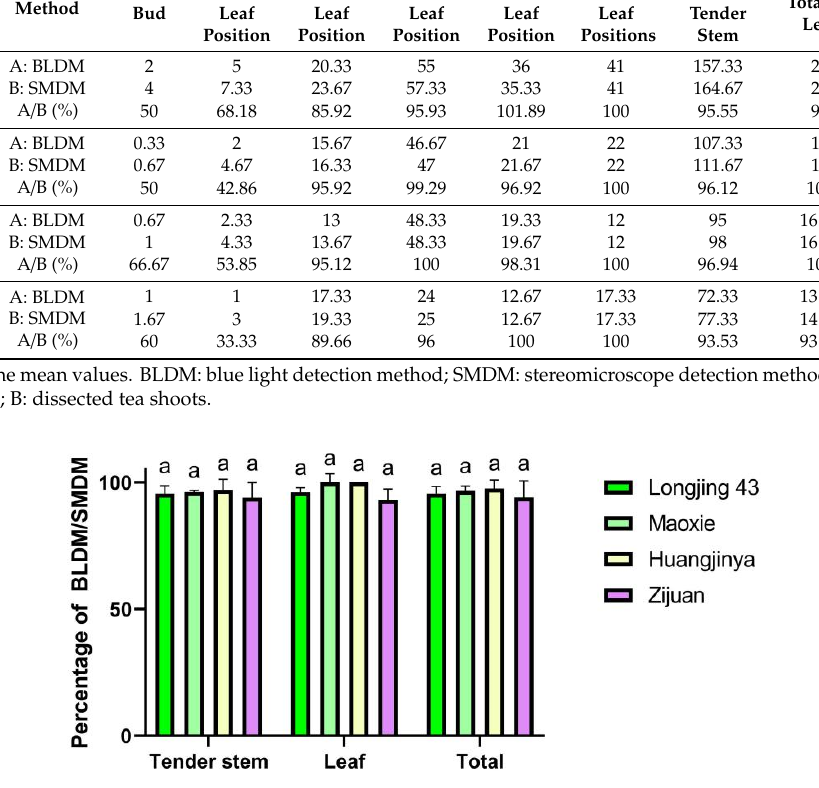
Figure 2. Percentage of BLDM/SMDM for the egg detection of E. onukii at four tea cultivars. The same letter above each column indicates no significant difference among four cultivars.